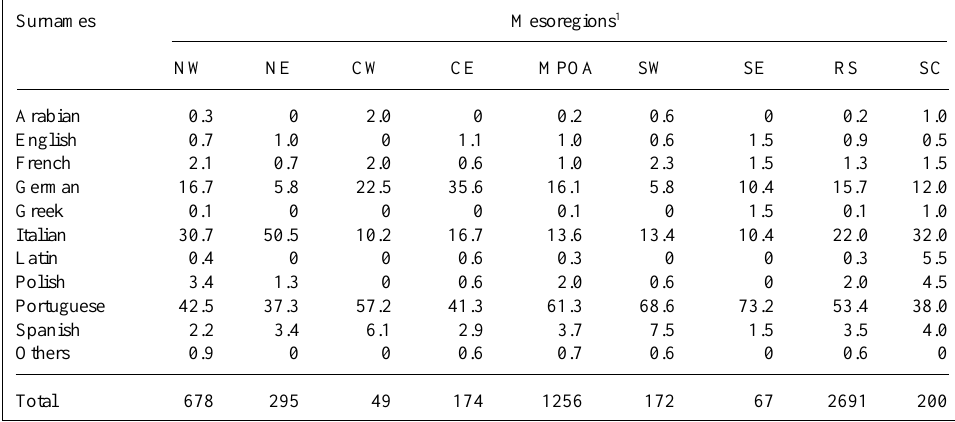
Table IV - Distribution (%) of the surnames of individuals living in the seven mesoregions of the State of Rio Grande do Sul (RS) and in Santa Catarina (SC).